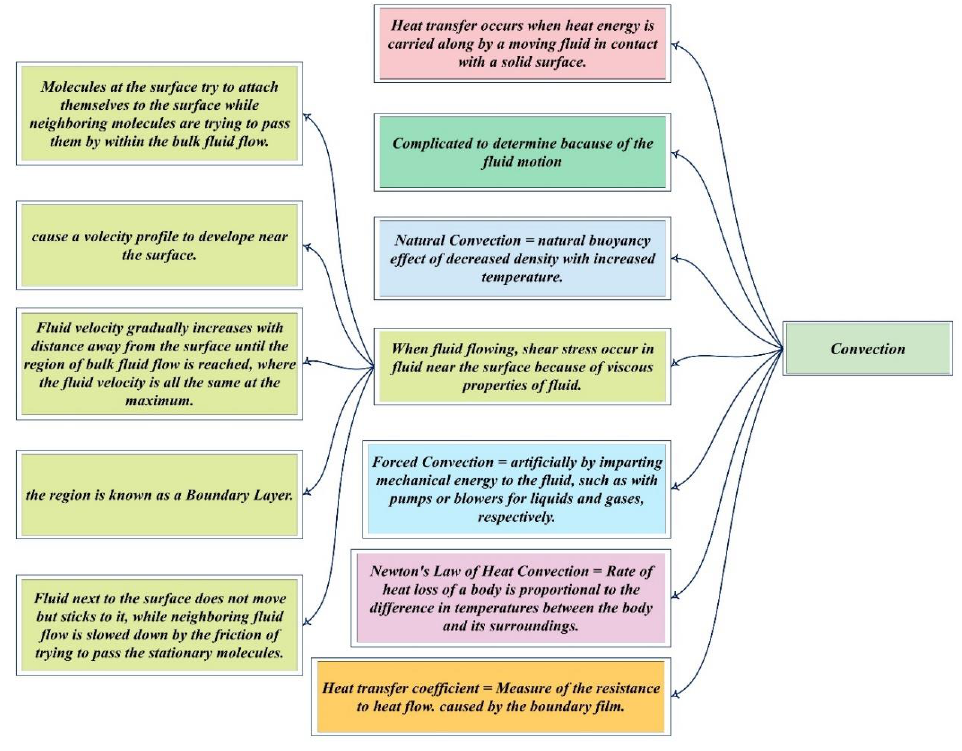
Figure 1. Types of heat transfer mechanisms and their subdivisions [1].